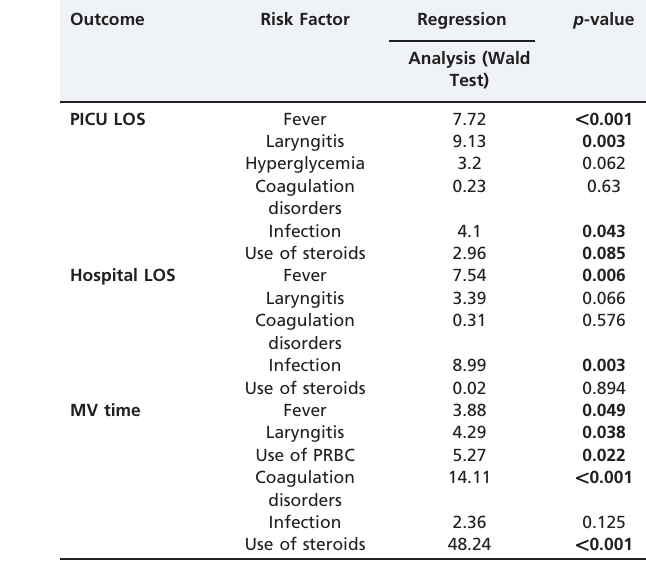
Table 3 - Results of multivariate